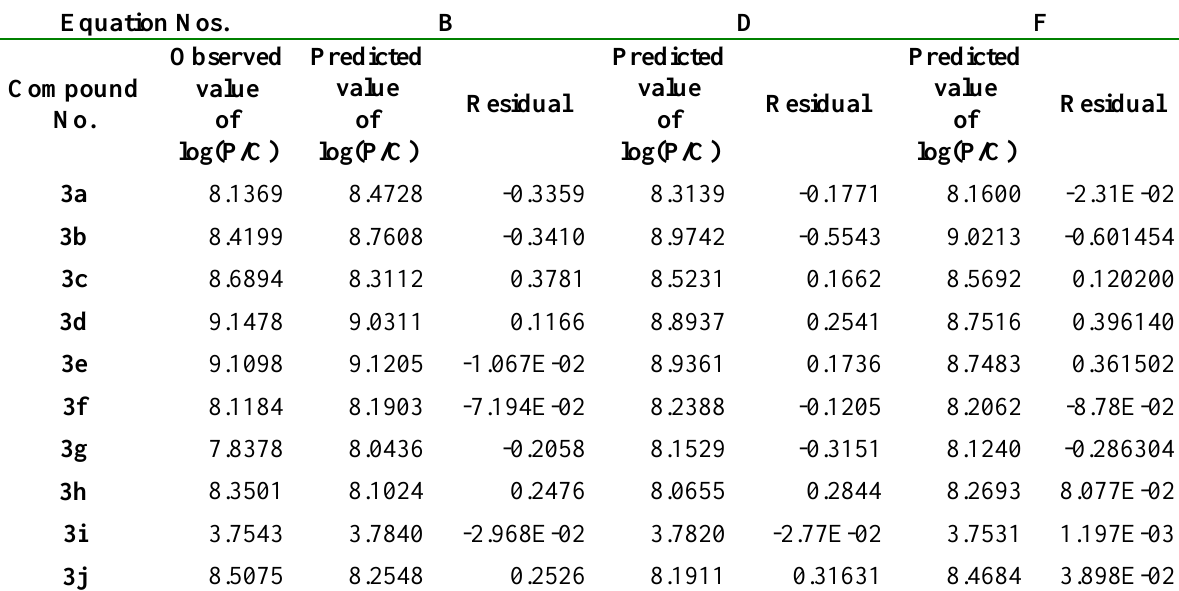
Table 5b: Compound-wise diagnostics values of regression analysis for Gram Positive bacteria. Equation